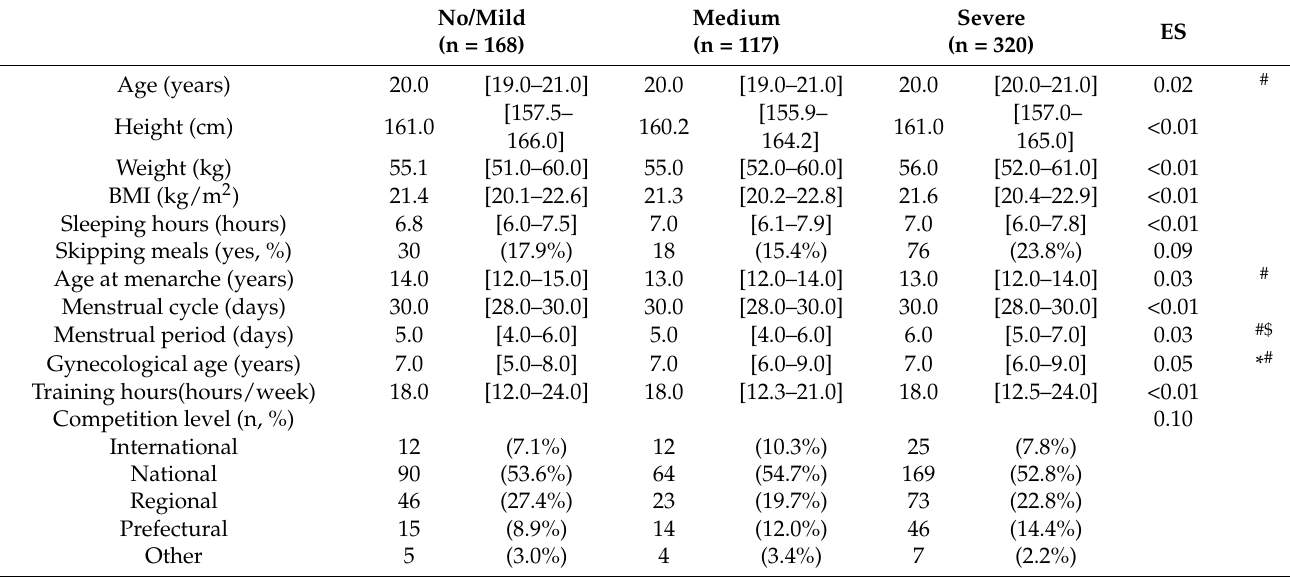
Table 3. Characteristics by severity of dysmenorrhea in non-athletes.